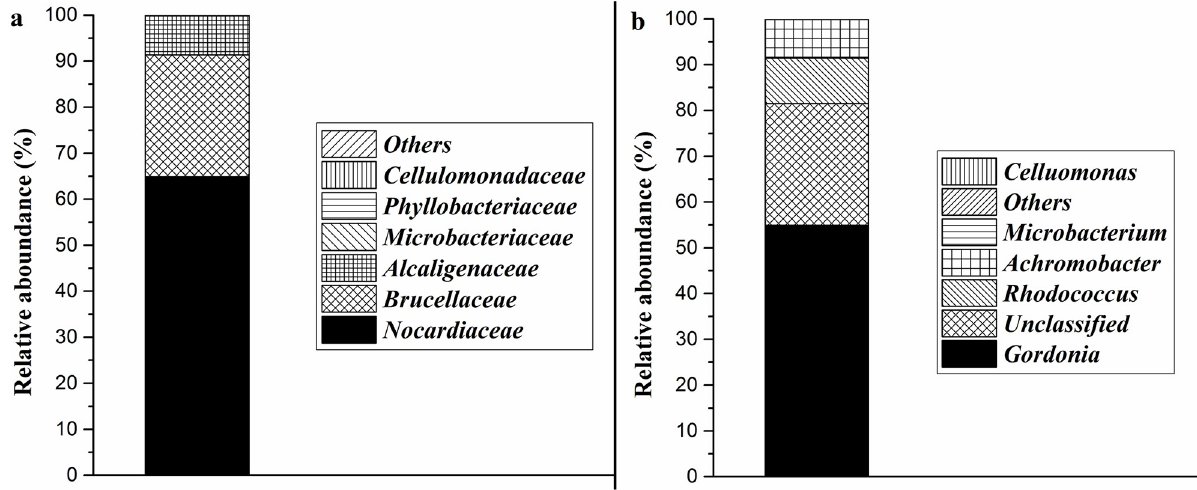
Fig 1. Bacterial community structure of LF. (a) at family level; (b) at genus level.